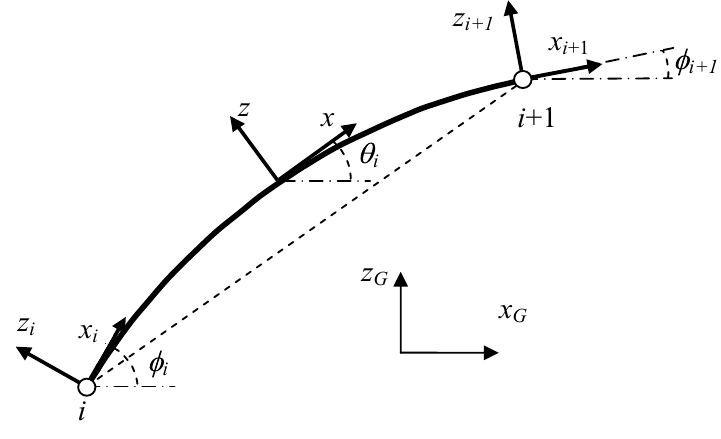
Fig. 2. Sketch of angles between tangents to the element and the global axis, represented by x G and z G